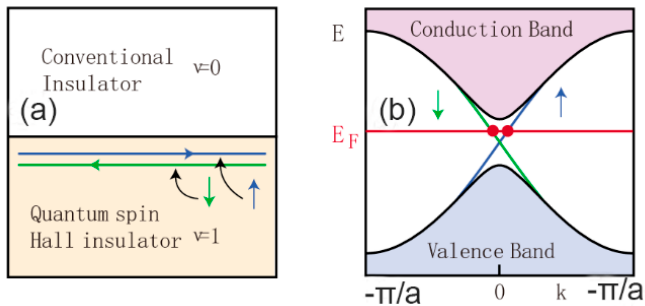
Figure 3. Edge states in the quantum spin Hall insulator (QSHI). ( a ) The interface between a QSHI and an ordinary insulator. ( b ) The edge state dispersion in the graphene model in which up and down spins propagate in opposite directions [50]. Copyright 2012, American Physical